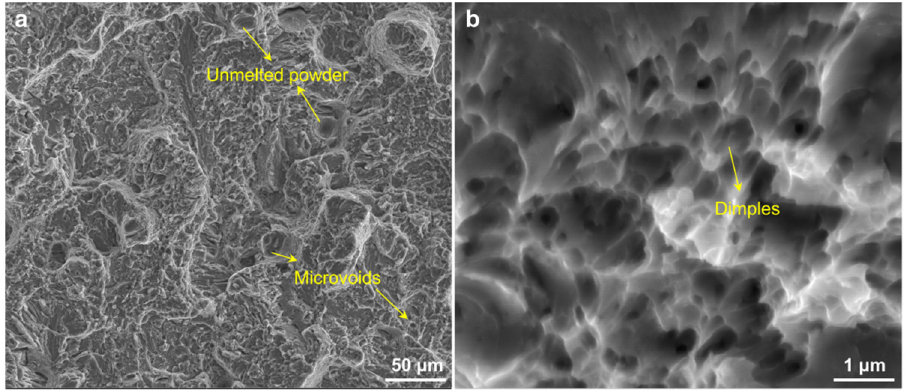
Figure 7. ( a ) SEM micrographs showing the unmelted and microvoids on fracture of tensile specimens possessed at the VED of 95.8 J/mm 3 ; ( b ) Detailed fracture morphology showing fine